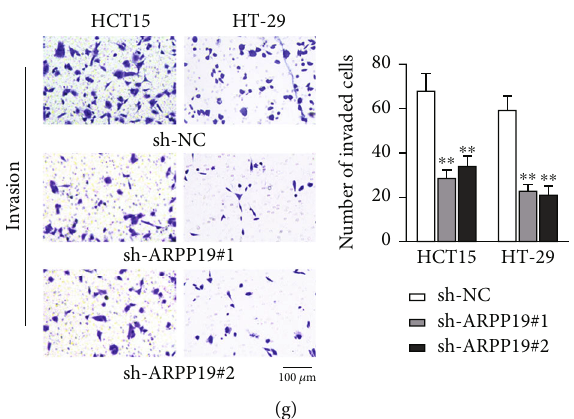
Figure 4: ARPP19 knockdown inhibits CRC cell malignant behaviors. (a) qRT-PCR measured the changes in ARPP19 expression after CRC cells were transfected with sh-NC, sh-ARPP19#1, or sh-ARPP19#2. (b, c) CRC cell proliferation was assessed via EdU assay and colony formation assay. (d, e) The apoptosis capability of transfected cells was evaluated by TUNEL and JC-1 assays. (f, g) Cell migration and invasion abilities were assessed via transwell assay. ∗∗ p < 0 : 01